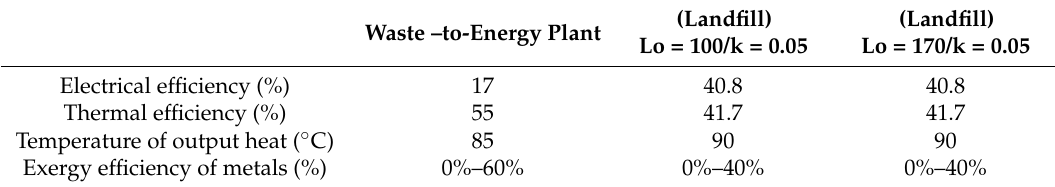
Table 1. Parameters of representative plants for the calculation of the R1 formula and 3T method for the comparison of waste-to-energy and landfilling.